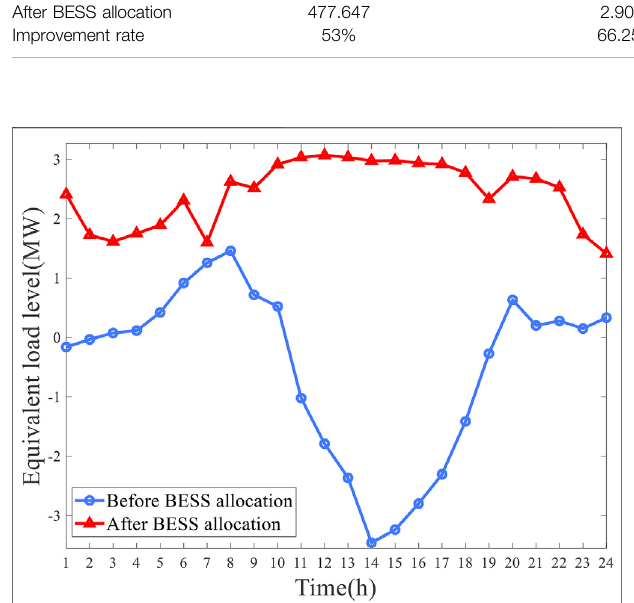
FIGURE 9 | Average node voltage curves under two cases.